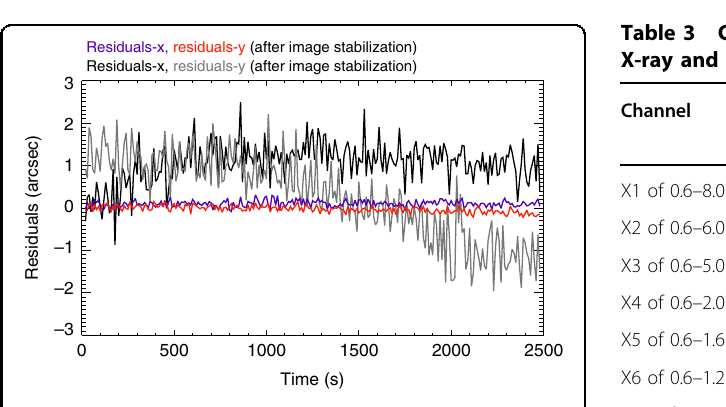
Fig. 14 Residuals before and after image stabilization